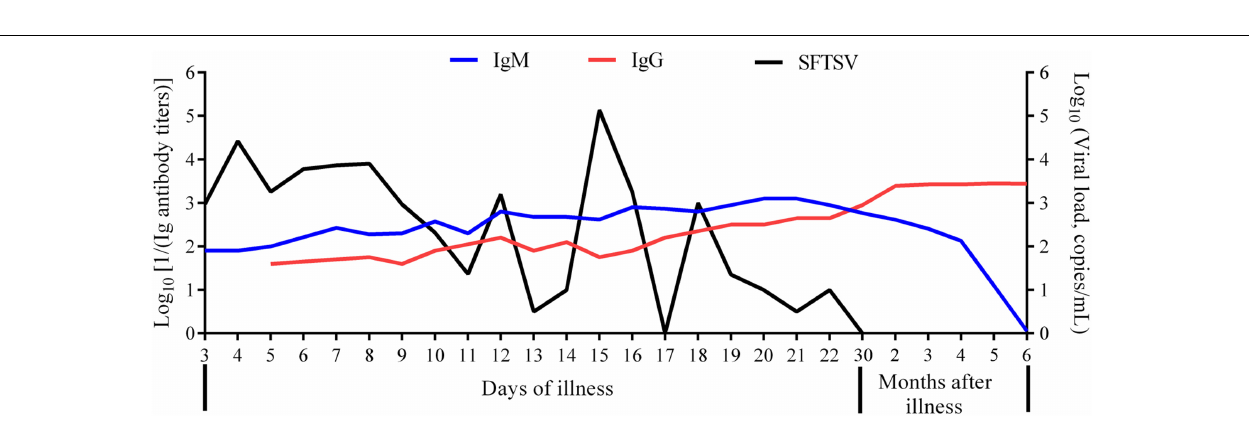
FIGURE 2 | Change trends of SFTSV, IgM, and IgG in patients of severe fever with thrombocytopenia syndrome. SFTSV, severe fever with thrombocytopenia syndrome virus; IgM, immunoglobulin M; IgG, immunoglobulin G. The viral load was in the format of Log 10 viral RNA copies/ml. The IgM titers were in the format of Log10 [1/(IgM antibody titers)]. The IgG titers were in the format of Log10 [1/(IgG antibody titers)].